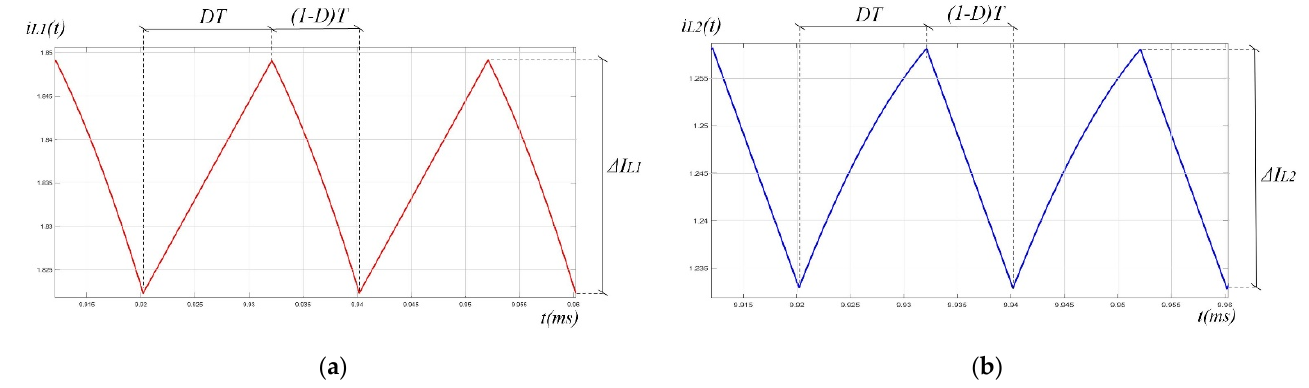
Figure 3. Converter currents in time domain: ( a ) current I L1 ; ( b ) current in the inductor I L2 . The currents i L 1 (t) , i L 2 (t), and i S 2 (t) present three different ripples, Δ i L 1 (t) , Δ i L 2 (t) , and